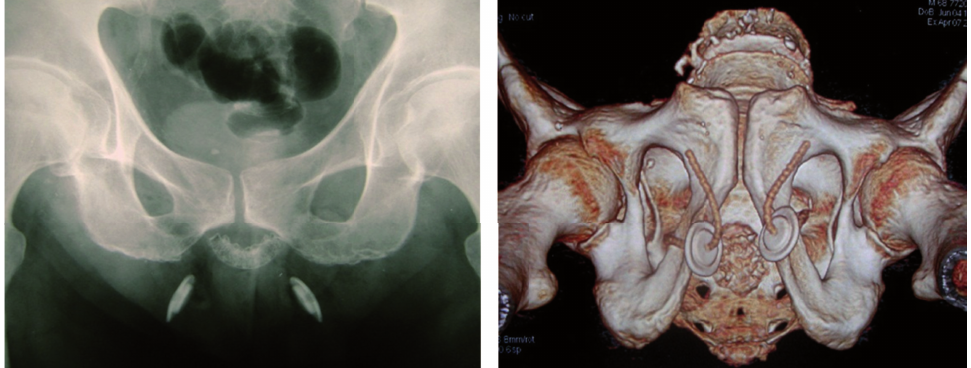
Figure 4 - Left – fi nal position of the implant in a plain x-ray. Right – fi nal position of the implant in a MRI 3D